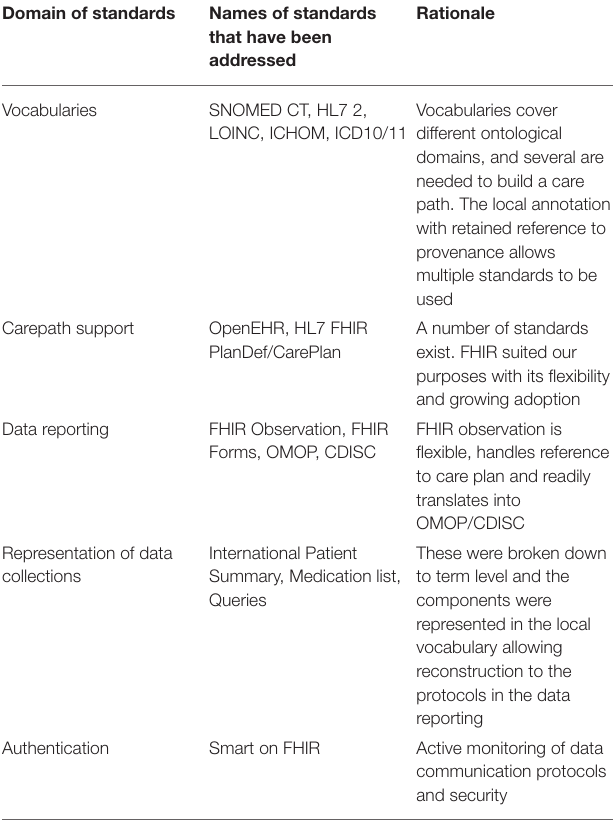
TABLE 3 | An overview of the standards that the project considered in the development of a multipurpose care plan strategy. Domain of